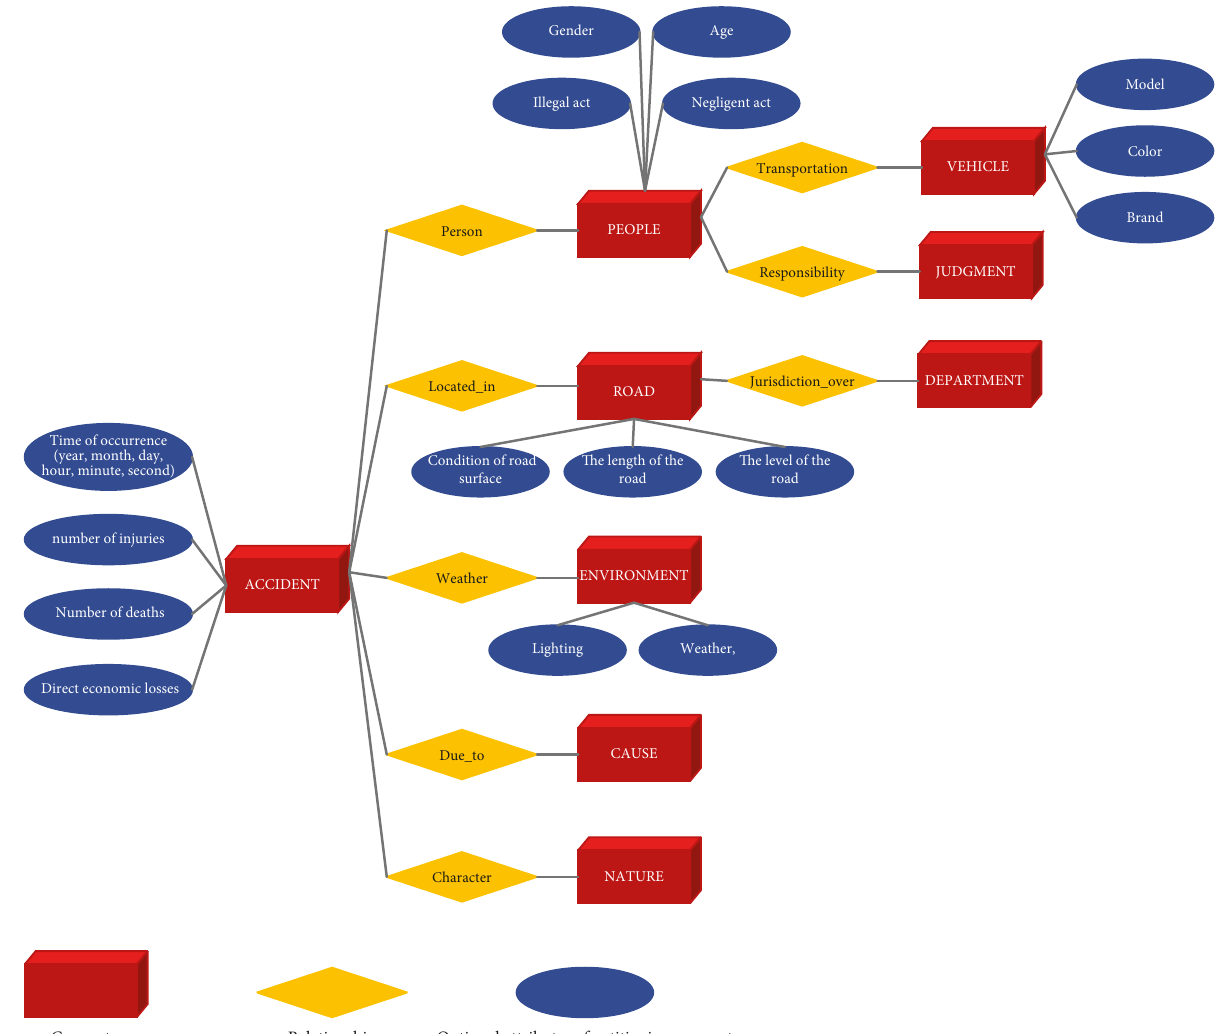
Figure 4: Conceptual and relational schema structure diagram of traffic accident knowledge graph.